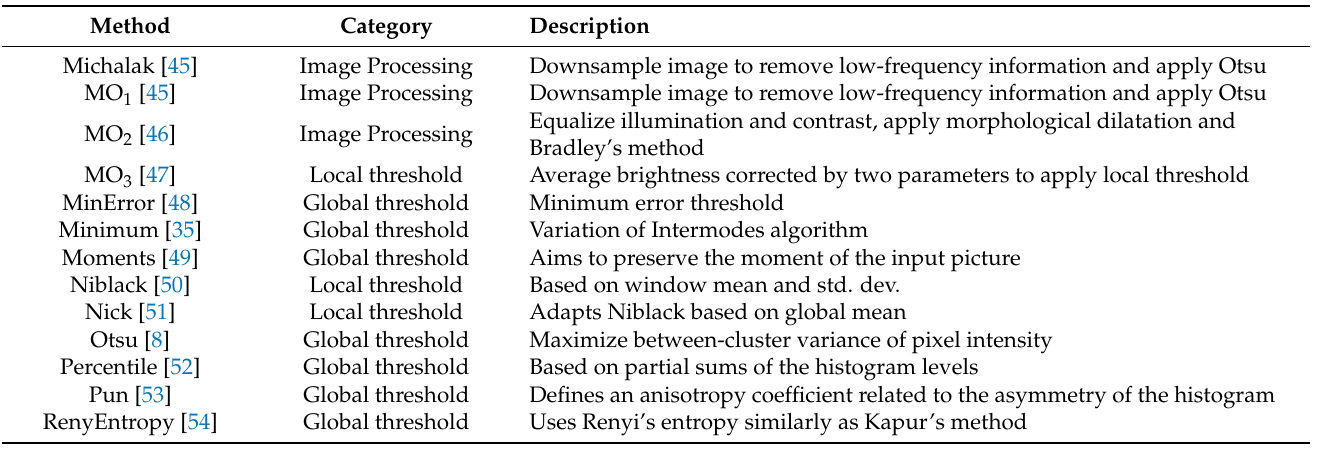
Table 2. Tested binarization algorithms—Part